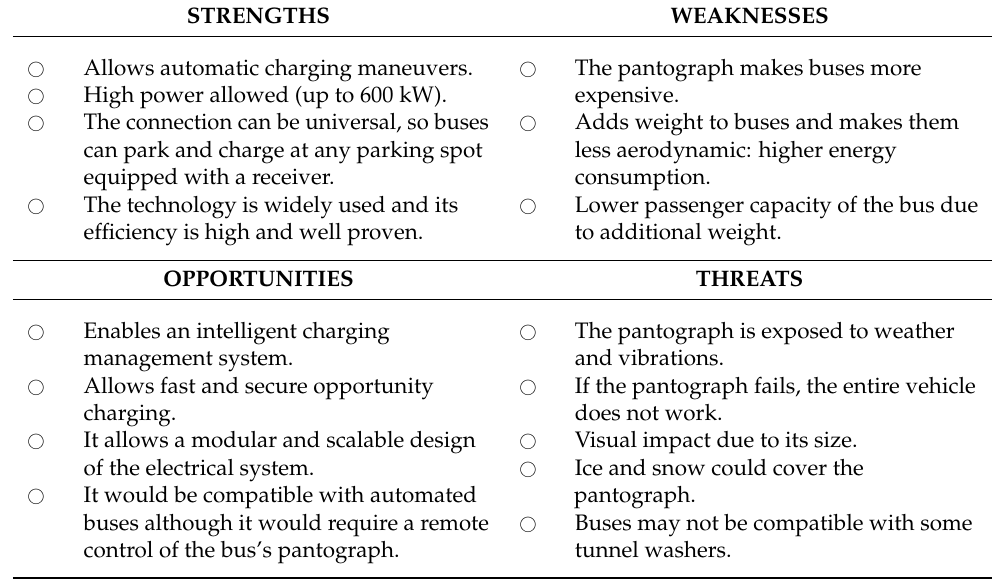
Table 5. SWOT analysis of Traditional pantograph or panto ‐